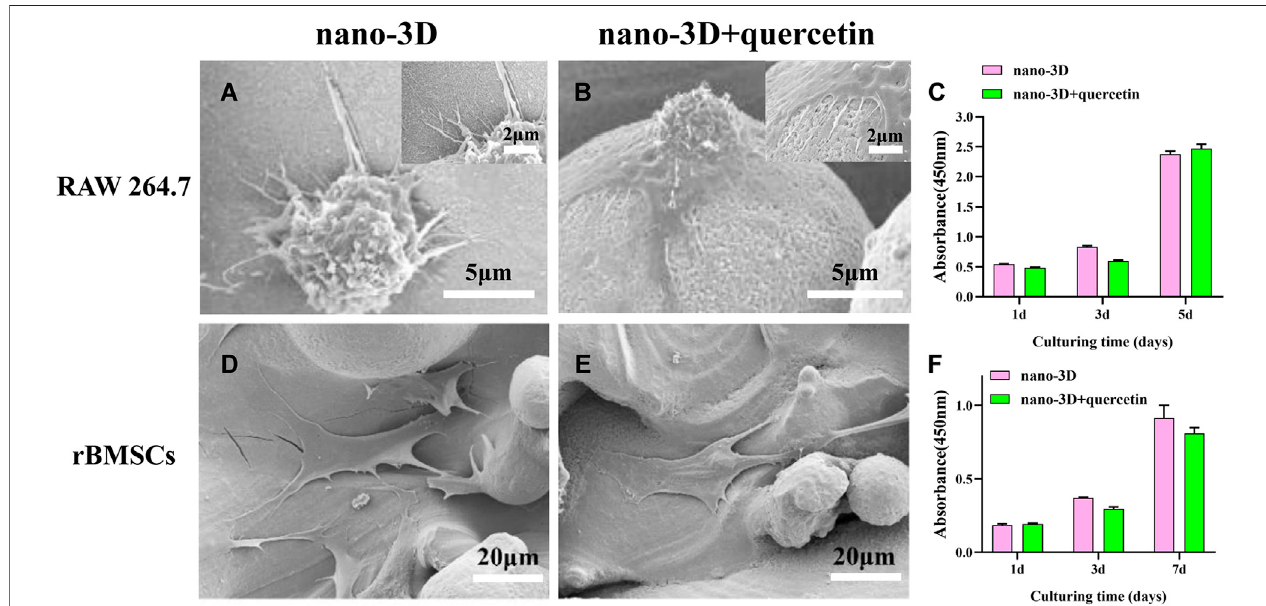
FIGURE 2 | SEM images of adherent RAW 264.7 (A,B) and rBMSCs (D – E) cultured on nano-3D (A,D) and nano-3D + quercetin (B,E) ; CCK-8 analysis of RAW 264.7 (C) and rBMSCs (F) cultured on nano-3D and nano-3D + quercetin samples (* p < 0.05).